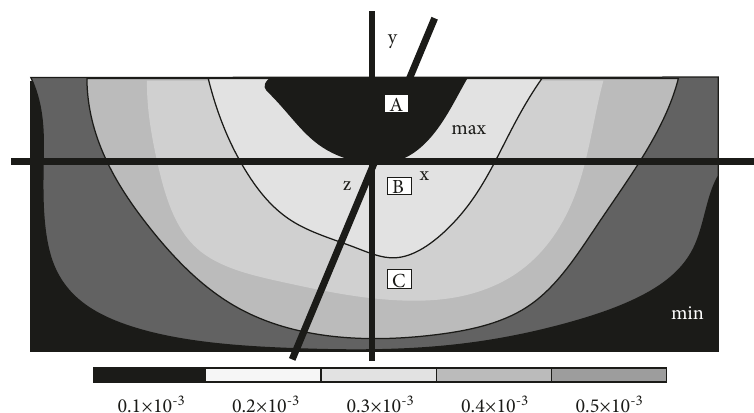
Figure 4: The displacement distribution of points a, B, and C in the ( x , y , z )